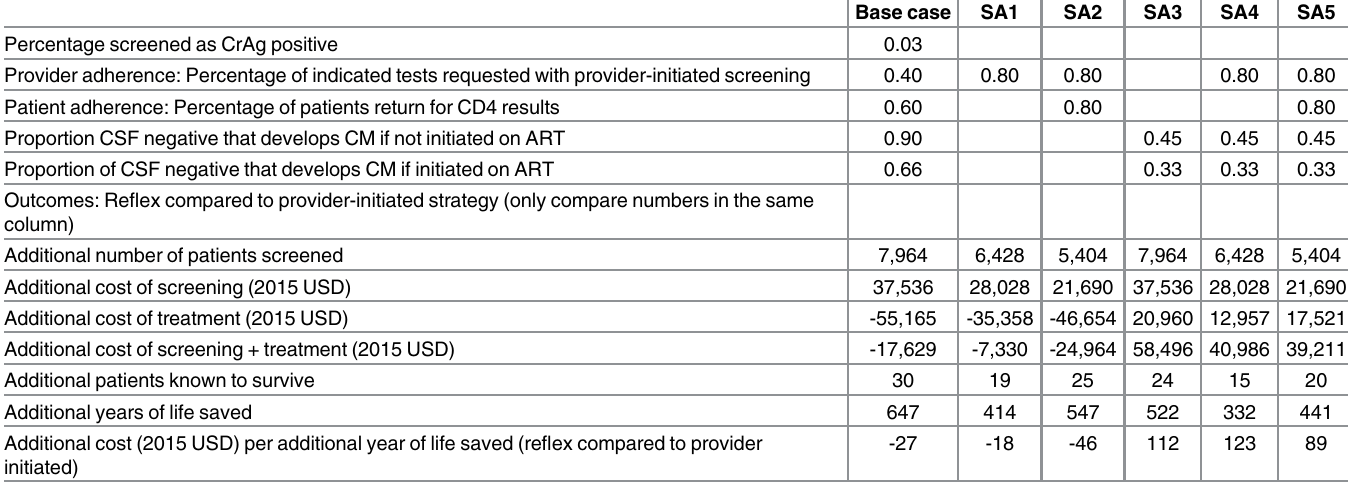
Table 6. Sensitivity analyses (all cost in 2015 USD, per 100,000 CD4 tests) a